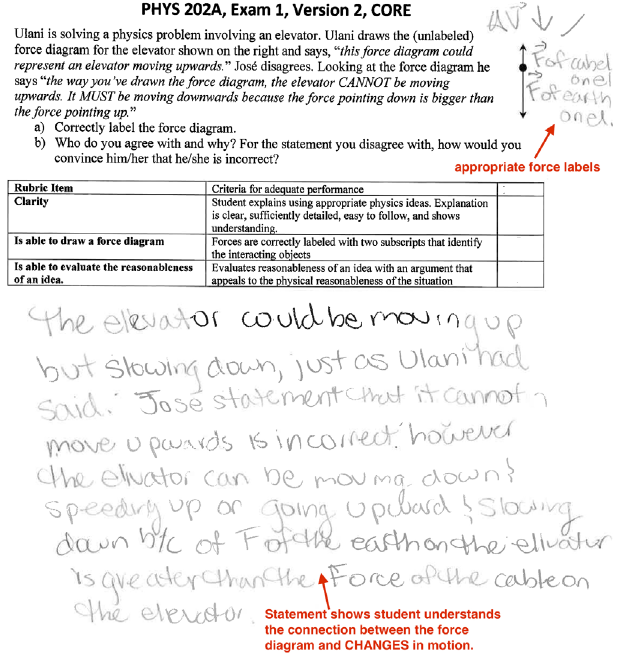
FIG. 10. Student ’ s 2nd attempt at force and motion and evaluation scientific abilities